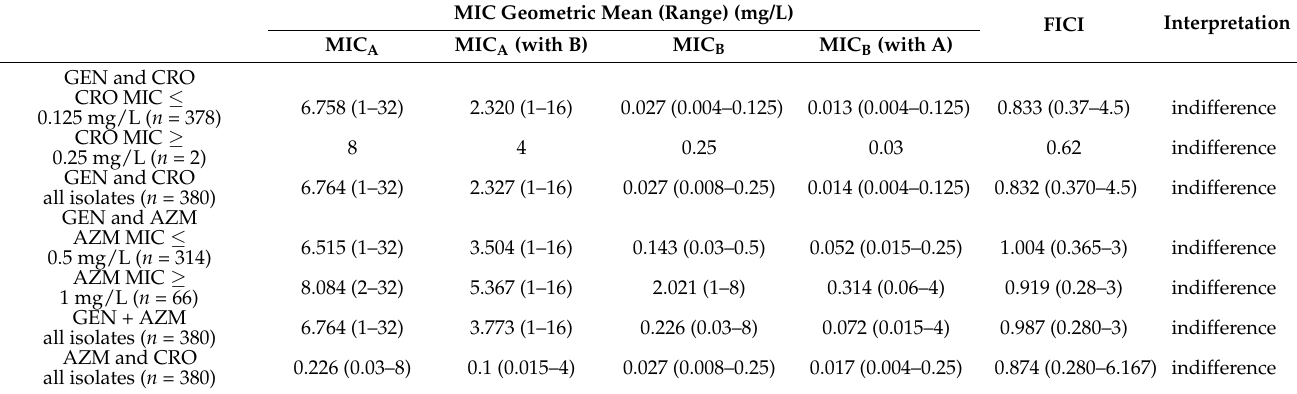
Table 3. MICs geometric mean and range of the indicated antibiotics as monotherapy and in combi-